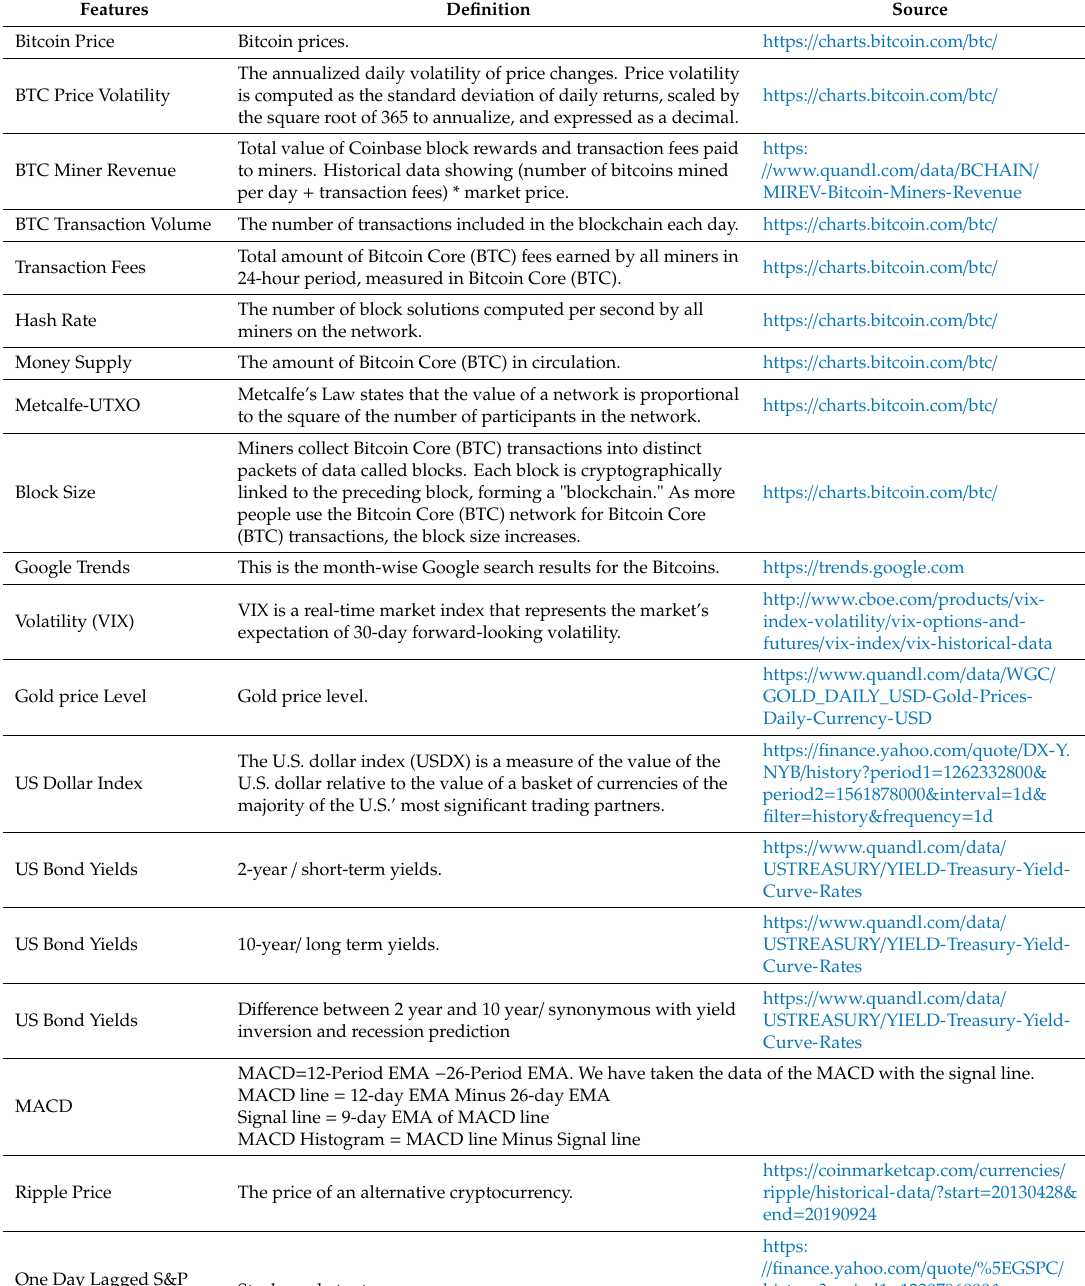
Table A1. Definition of variables and data